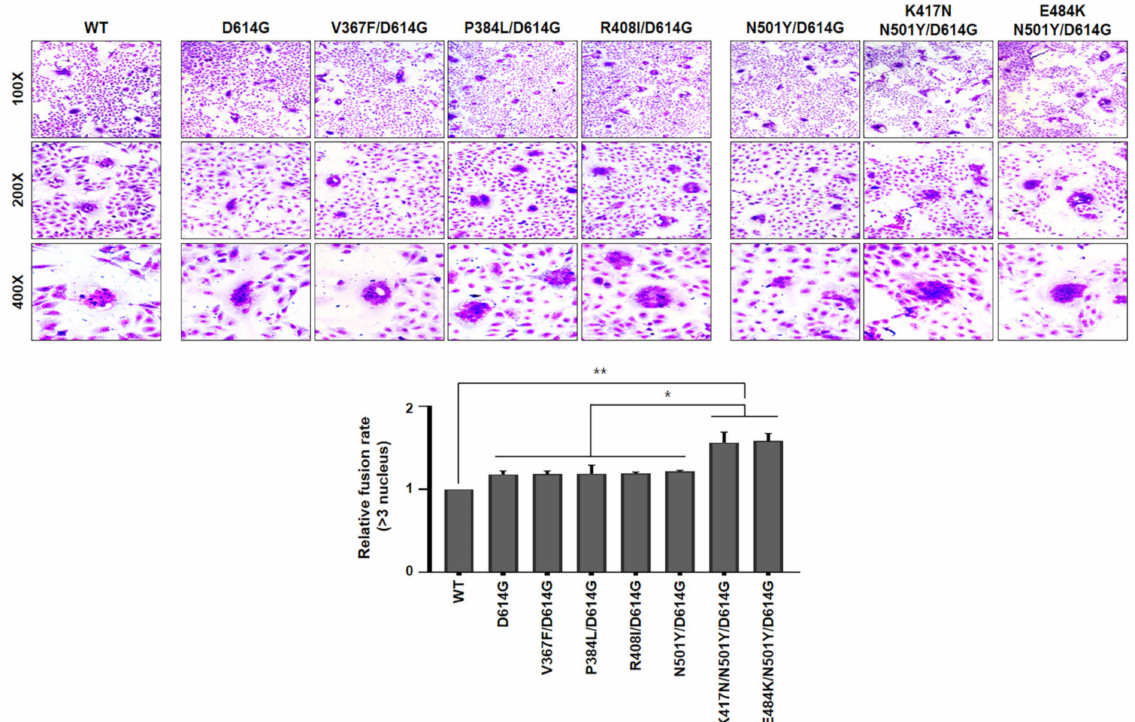
Figure 4. Cell-to-cell membrane fusion assay (syncytium formation assay) (Below) Vero cells were transfected with plasmids expressing each SARS-CoV-2 Spike RBD variant. At 24 h post-transfection, cells were treated with trypsin (1 µ g/mL) before they were fixed, followed by staining with crystal violet. Representative images were captured at the indicated magnifications, and the number of syncytia containing more than three nuclei was counted. Fusion rate was calculated by dividing nuclei number in syncytia by total nuclei number (minimum 3000 total nuclei). The relative fusion rate was calculated by comparing SARS-CoV-2 Spike RBD mutants to WT and shown as a graph. Data represent the mean ± SEM. Statistical analysis was conducted using a two-tailed Student’s t -test. *, p < 0.05; **, p <